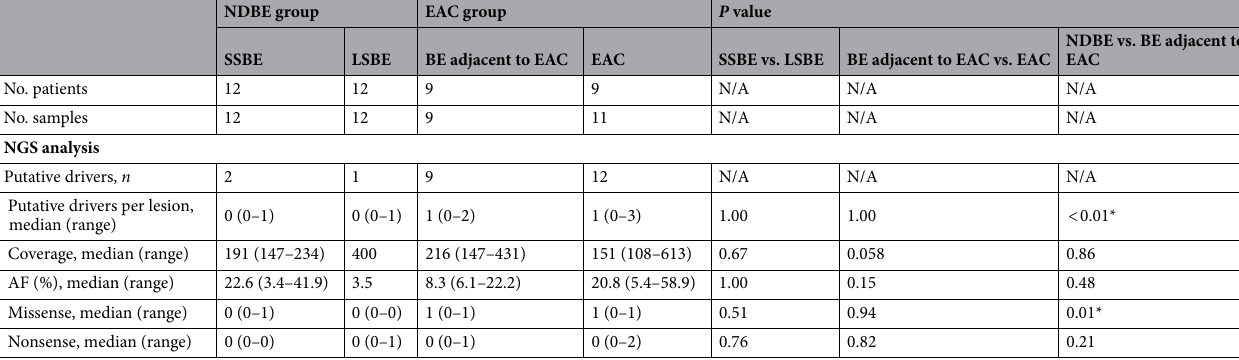
Table 3. Differences in next-generation sequencing results between nondysplastic Barrett’s esophagus and esophageal adenocarcinoma. AF Allele frequency, BE Barrett’s esophagus, EAC esophageal adenocarcinoma,